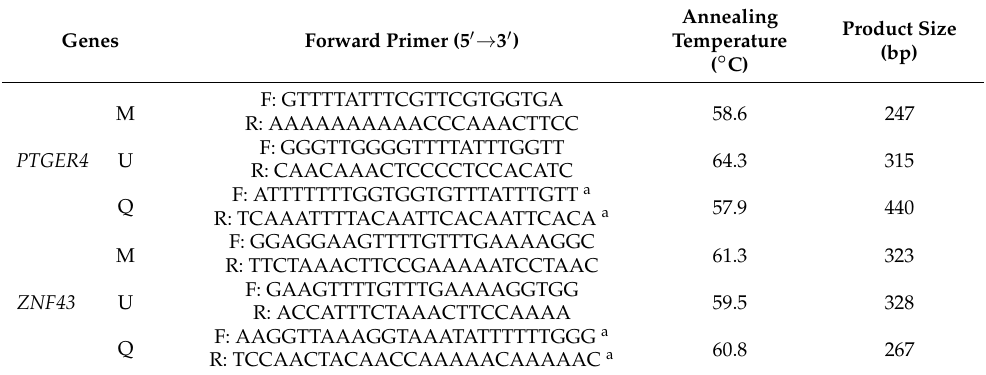
Table 6. Primer sequences, annealing temperature, and product size for MS-PCR and EpiTYPER DNA methylation analysis of candidate